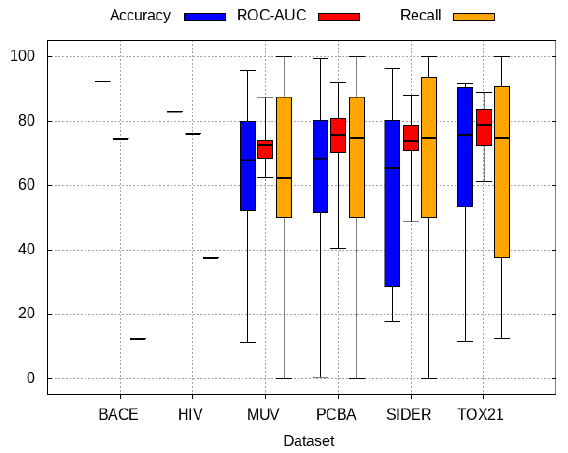
Figure 4. The average change in performance and ROC-AUC of after transfer learning from each dataset.